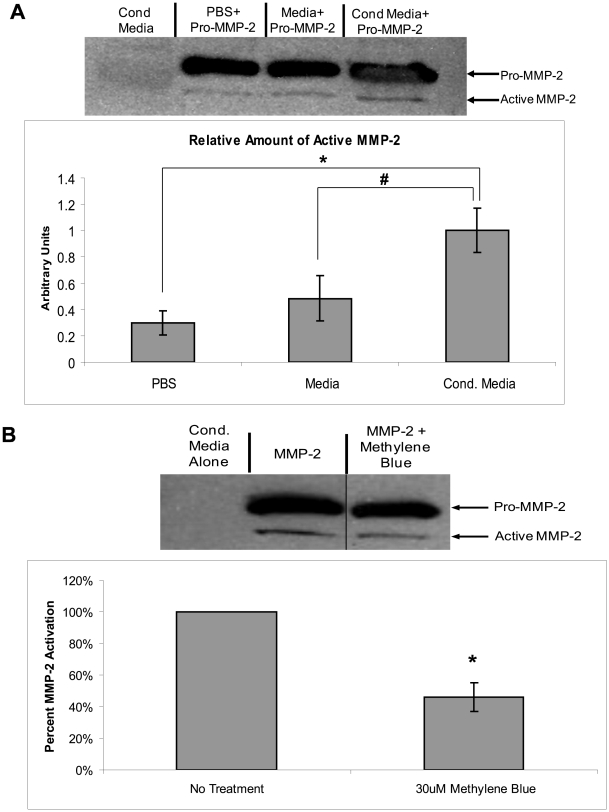
Conditioned media from cancer cells contains necessary components to activate MMP-2.(a) Conditioned media was collected from MDA-MB-231 cells, samples were incubated with and without 0.75 µg pro-MMP-2 for 5 minutes and the relative amount of active MMP-2 was analyzed via SDS-PAGE. (b) Conditioned media was collected and then treated with 30 µM Methylene Blue. 0.75 µg recombinant pro-MMP-2 was added to treated and untreated conditioned media. Samples were incubated at room temperature for 5 minutes and the relative amount of active MMP-2 was analyzed via SDS-PAGE. The difference in overall band intensity was taken into account in the densitometry calculations. Experiments were repeated three times. (* P-value<0.01, #P-value<0.05).